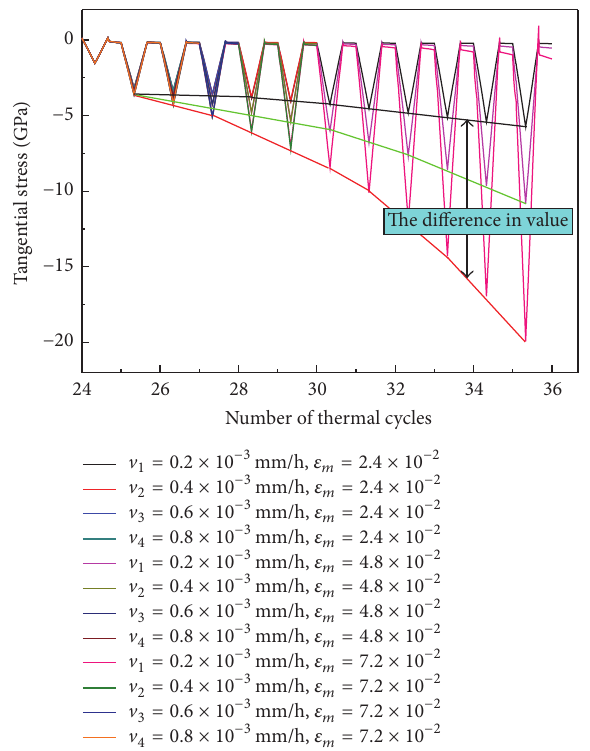
Figure 7: The variation of the tangential stress at element number 20857atthebaseofthesurfacegrooveagainstthenumberofthermal cycles when 𝜀 𝑚 = 2.4 × 10 −2 , 𝜀 𝑚 = 4.8 × 10 −2 , and 𝜀 𝑚 = 7.2 × 10 −2 .